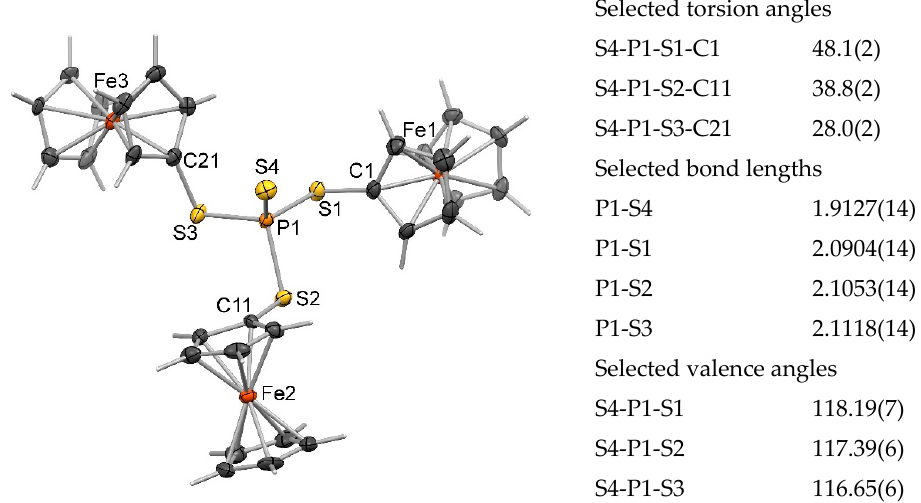
Figure 1. ORTEP drawing of 3 at the 50% probability level and selected geometrical parameters. Interestingly, one can see that bond lengths and valence angles at phosphorus change in concert with the orientation of ferrocenyl groups, i.e., the smaller is the torsion angle, the larger is the bond length and smaller is the valence angle. As expected, the bond lengths change in shorter limits ranging from 2.0904(14) to 2.1118(14) Å. The valence angles at phosphorus atom range from 116.65(6) to 118.19(7)°, while the valence angles at all sulphur atoms are the same within experimental errors, the average value is equal to 100.4°.